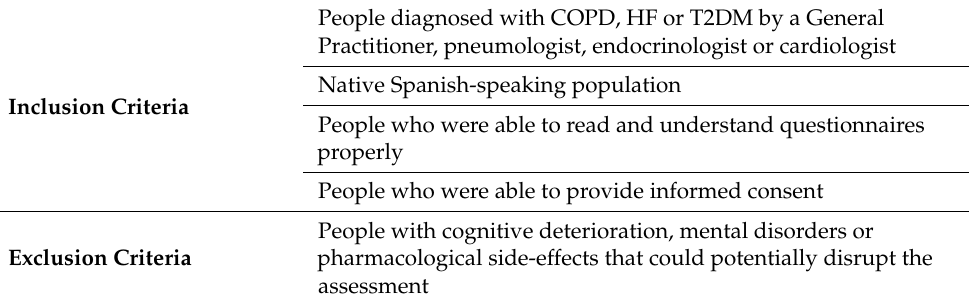
Table 1. Inclusion and exclusion